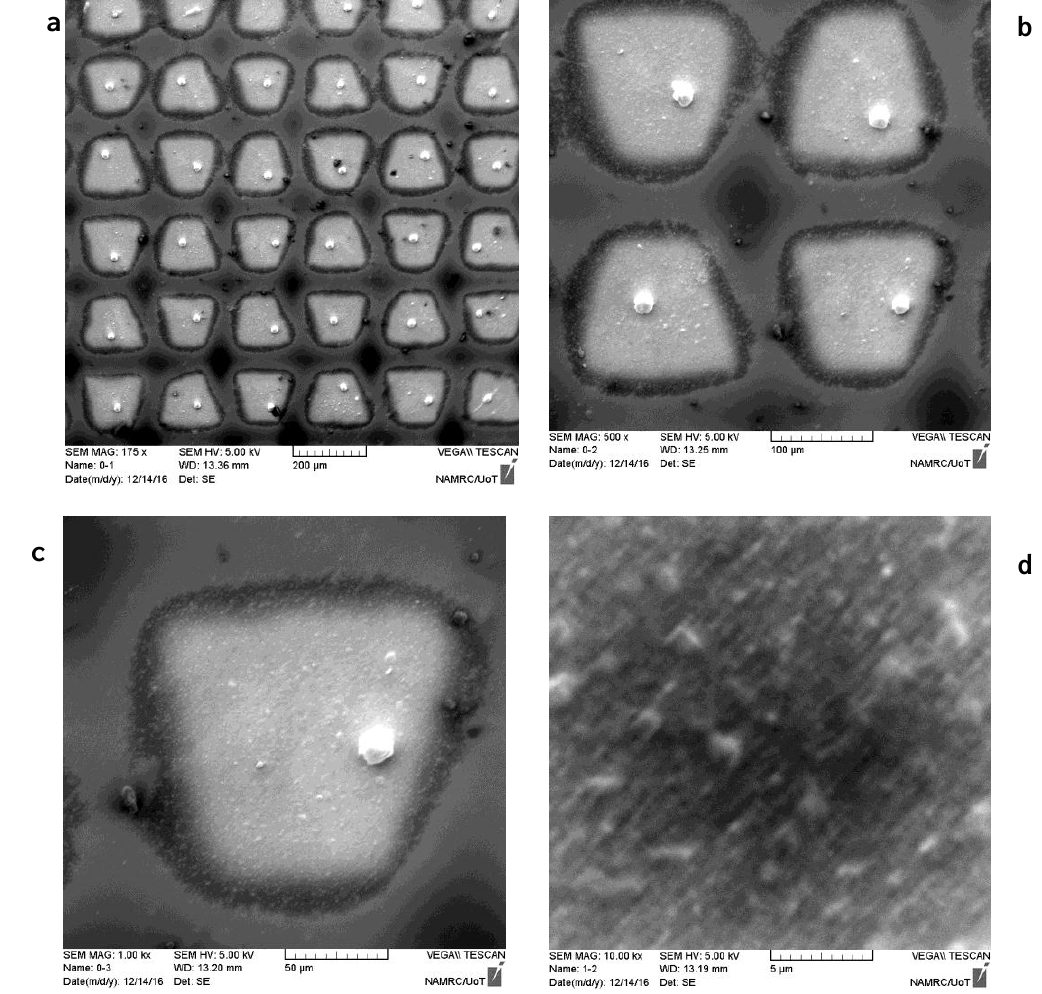
Fig. 4: SEM analysis of In magnification a)200 µm, b)100 µm , c)50 µm and d) 5